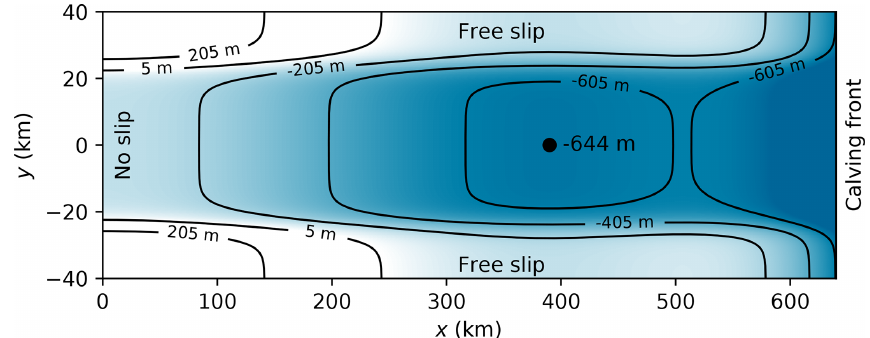
Figure 2. MISMIP+ domain showing bedrock elevation z b (x,y) and boundary types. The spot height ( − 644m) indicates the beginning of a retrograde slope in the center of the